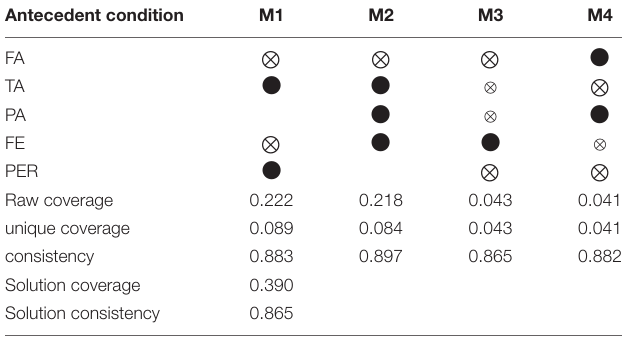
TABLE 2 | Paired sample T -test. Paired sample Control group